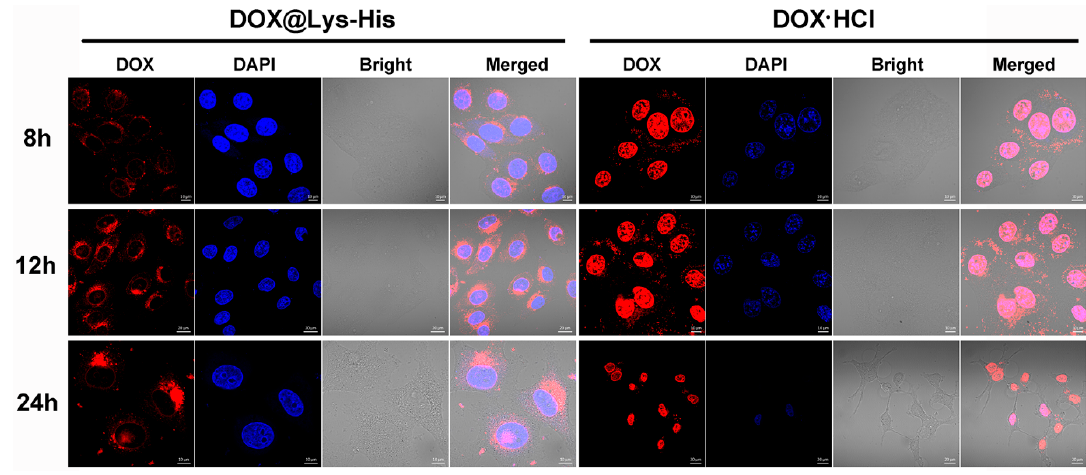
Figure 8. Confocal laser scanning microscopy (CLSM) of HepG-2 cells treated with DOX@ Lys-His and free DOX · HCl with [DOX] = 0.5 µ g/mL at different times. For each row, from left to right: DOX (red); cell nucleus stained by 4 ′ ,6-diamidino-2-phenylindole (DAPI) (blue); bright field and merged image.